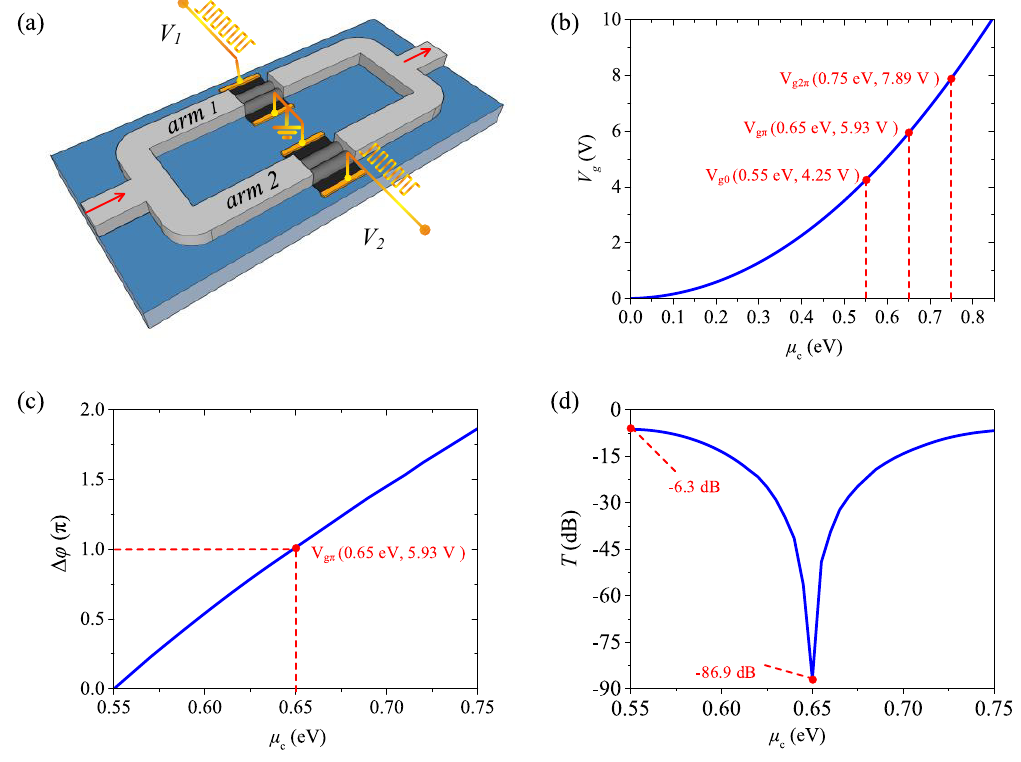
Figure 5: MZ modulator based on GMPs. (a) Schematic of the MZ modulator. (b) The relationship between the gate voltage V g and μ c . (c) Phase difference Δ φ as a function of μ c